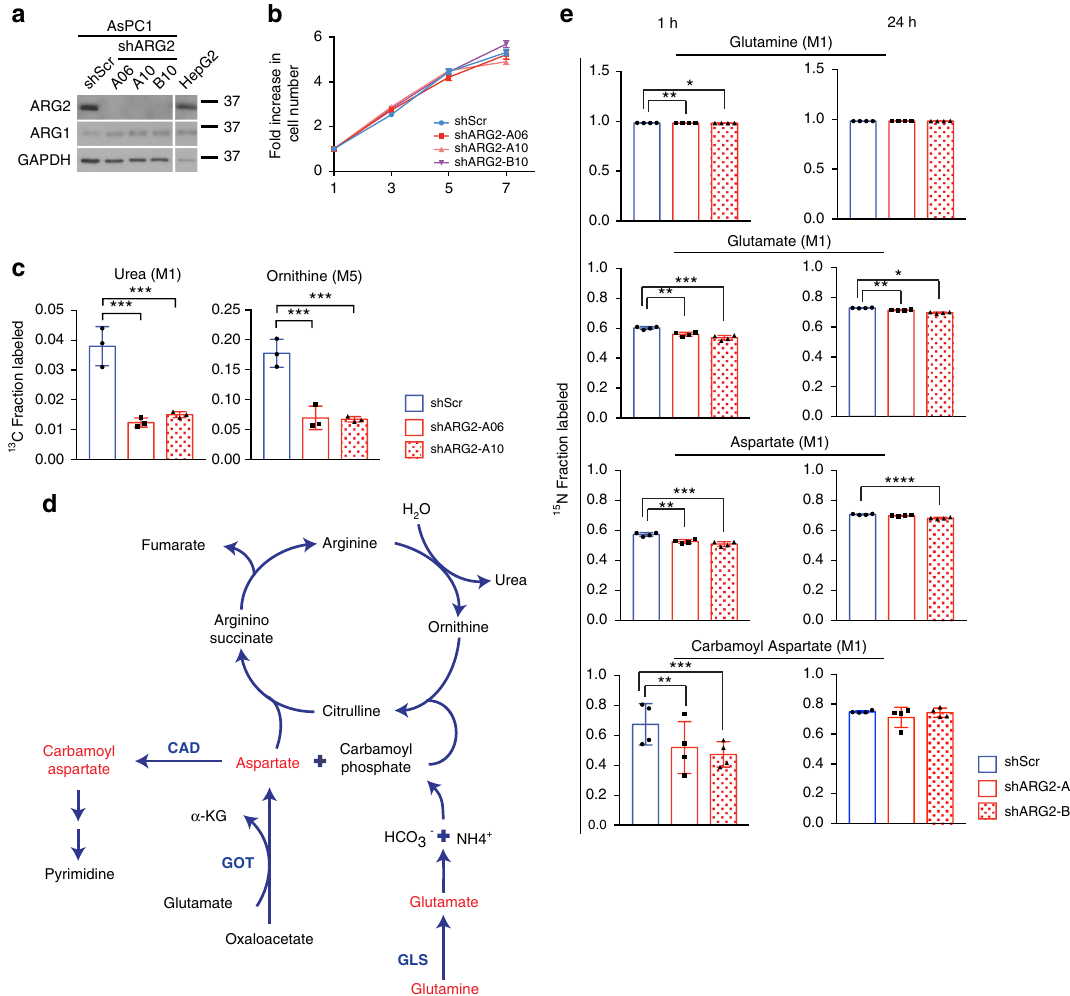
Fig. 2 Glutamine nitrogens do not integrate into the urea cycle in vitro. a Immunoblots for ARG2 and ARG1 in AsPC1-shScr and AspC1-shARG2 cells. b Proliferation curves of cells in a ( n = 6). Data are representative of 4 independent experiments. c Fractional 13 C-labeling of urea (M1) and ornithine (M5) in AsPC-1 cells with control (shScr) or ARG2 knockdown (shARG2, hairpins A06 and A10) grown in culture in 0.1% serum and 100 ng ml − 1 IGF-1, supplemented with 1 mM 13 C 6 -arginine for 48 h ( n = 4). d Diagram of the urea cycle, with metabolites in red indicating signi fi cant 15 N-labeling. e Fractional labeling of the indicated metabolites in cells described in a , grown in media supplemented with 2 mM 15 N(amine)-glutamine for 1 h or 24 h (n = 4). Data are representative of two independent experiments. In b , data represent the mean ± s.e.m. In c , e , data represent the mean ± s.d. * P ≤ 0.05, ** P ≤ 0.01, *** P ≤ 0.001, **** P ≤ 0.0001, by one-way ANOVA followed by Tukey